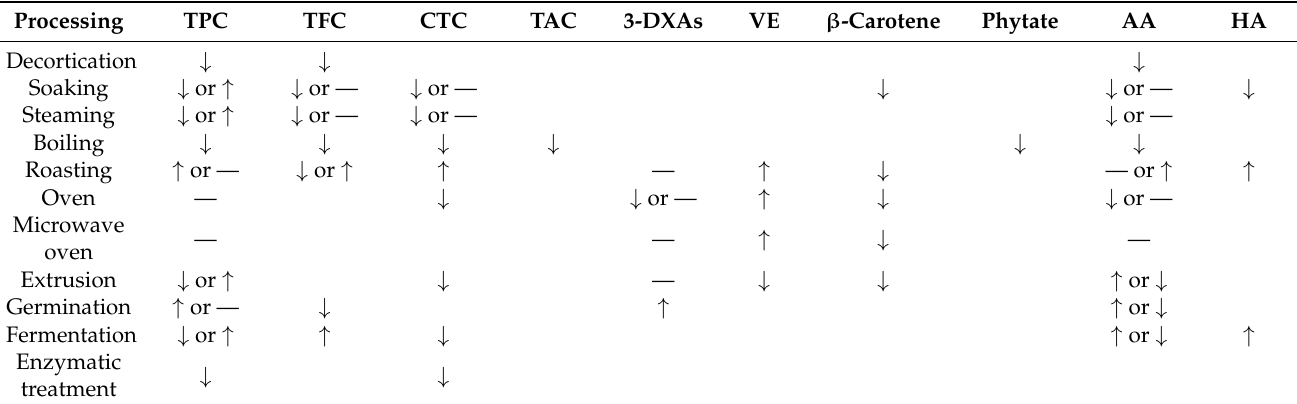
Table 1. Summarization of the changes of bioactive compounds and biological activities during different